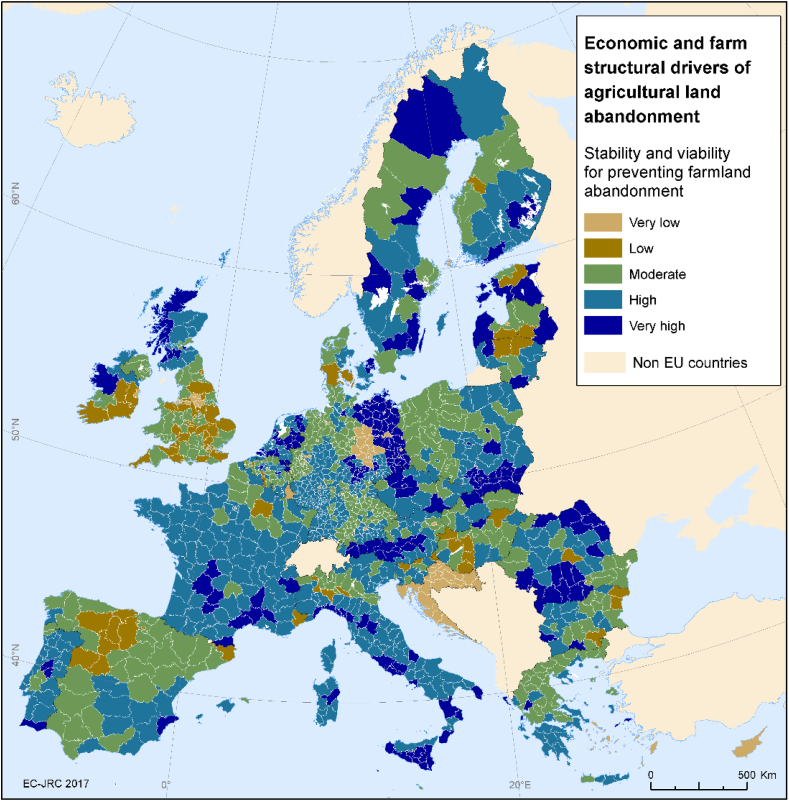
Map combining economic and farm structure drivers of agricultural land abandonment in the EU countries and the UK, period 2005–2010